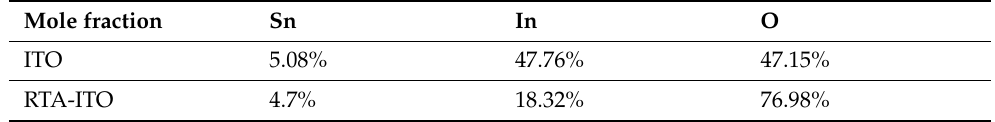
Table 1. The mole fraction ratio of the ITO X thin films from the XPS results. Mole